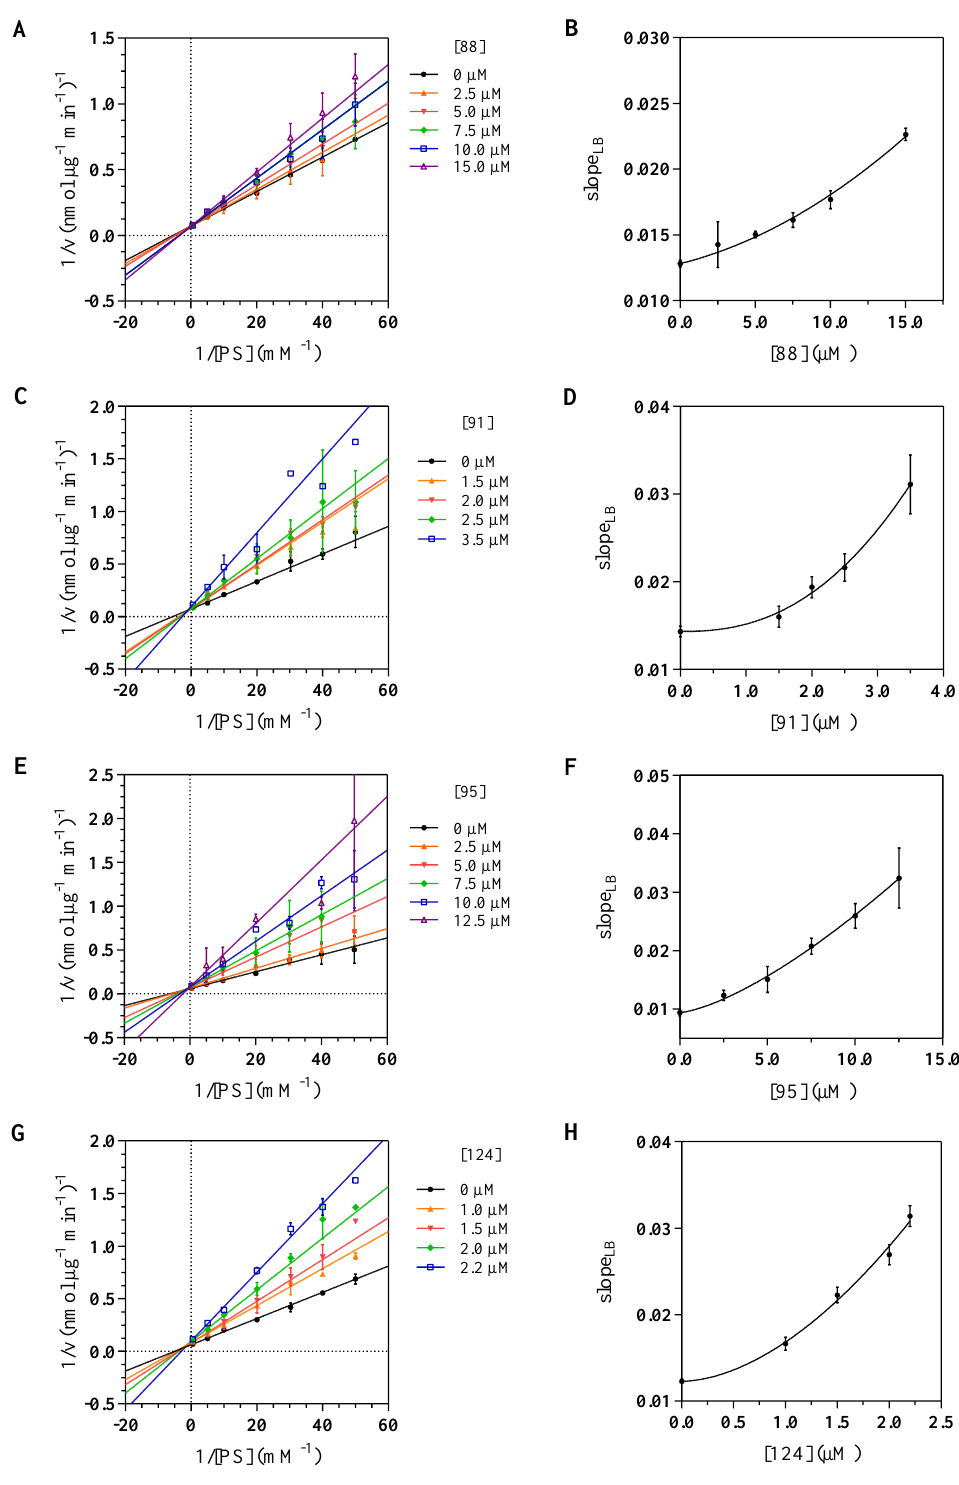
Figure 3. ( A , C , E , G ) Double reciprocal plots of SerB2 inhibition by compounds 88 , 91 , 95 and 124 at various fixed micromolar concentrations in presence of 0 to 2 mM O -phospho-L-serine (PS). The data depicted are averaged from two independent experiments ± S.E.; ( B , D , F , H ) Slope replots of double-reciprocal plots A, C, E and G versus inhibitor concentration ± S.E. on slope calculations. Solid line: fitted Hill-type function (Equation